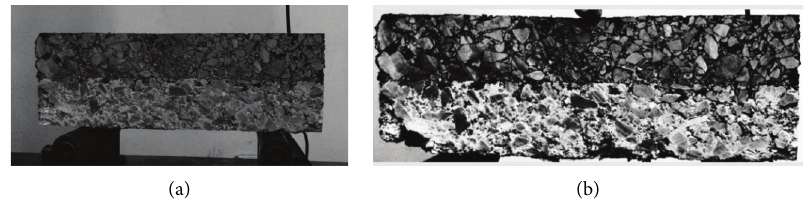
Figure 8: Image before binarization (a); image after binarization (b).